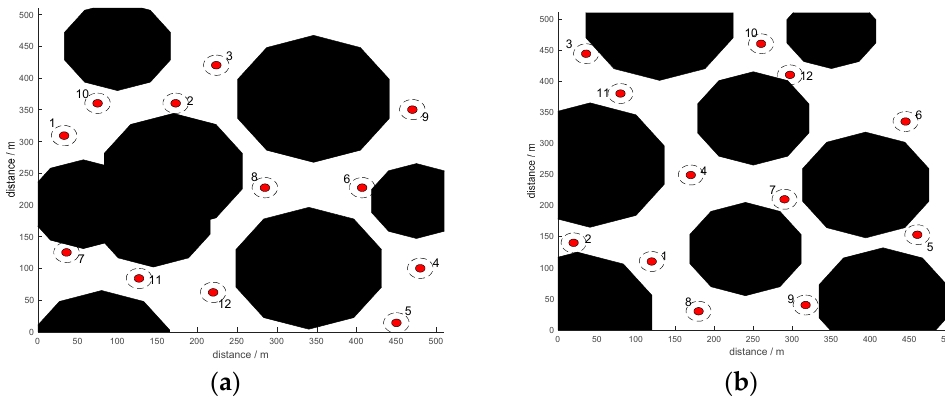
Figure 15. Initial positions of vehicles in MUVs under different maps. ( a , b ) are the initial positions for Map No. 1 and Map No. 2, respectively.